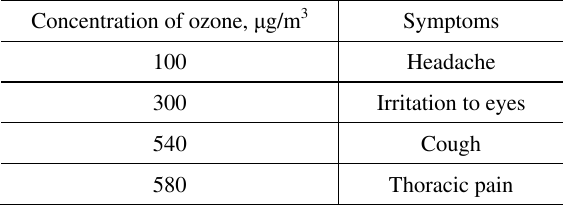
Table 1. Ailments at different concentrations of ozone Concentration of ozone, μ g/m 3